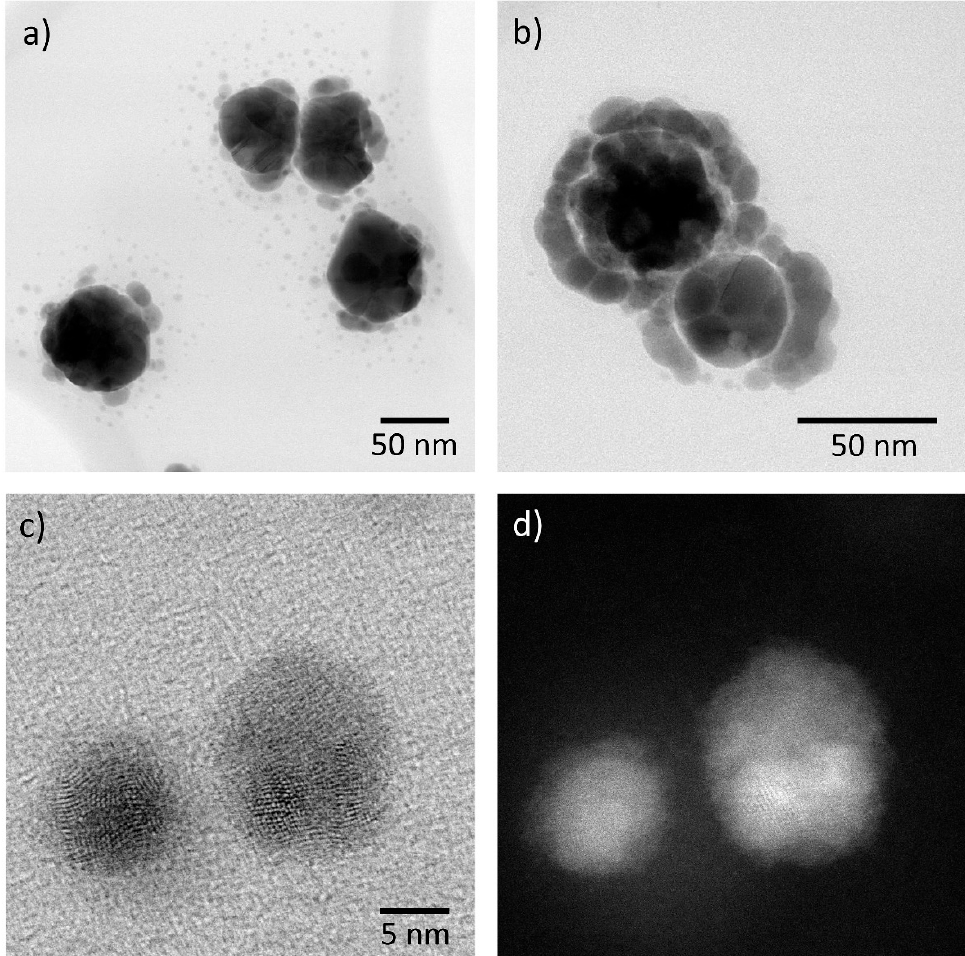
Figure 4. TEM images of silver nanoparticles exposed to ambient air at ( a ) medium and ( b ) low levels of humidity. Characteristic bimodal appearance of the corrosion product in ( c ) bright field (BF) and ( d ) annular dark field images (ADF).